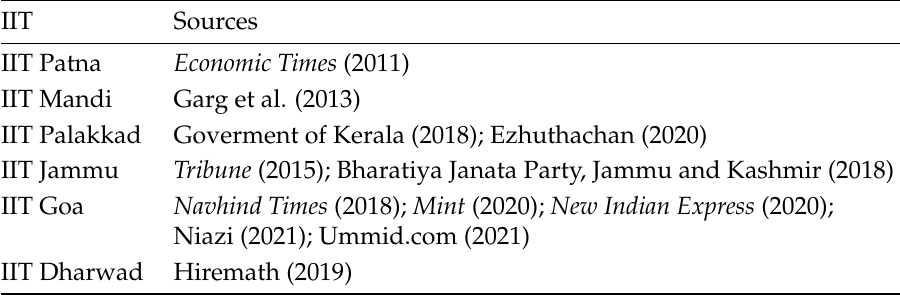
Table 1: Anchor institution strategy in IITs in underdeveloped